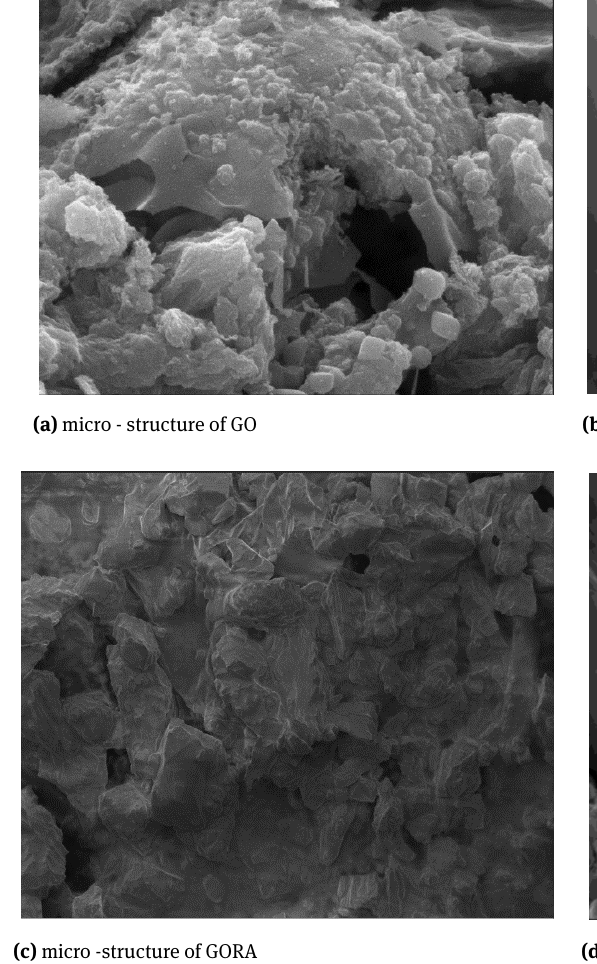
Figure 2: Microstructure of asphalt